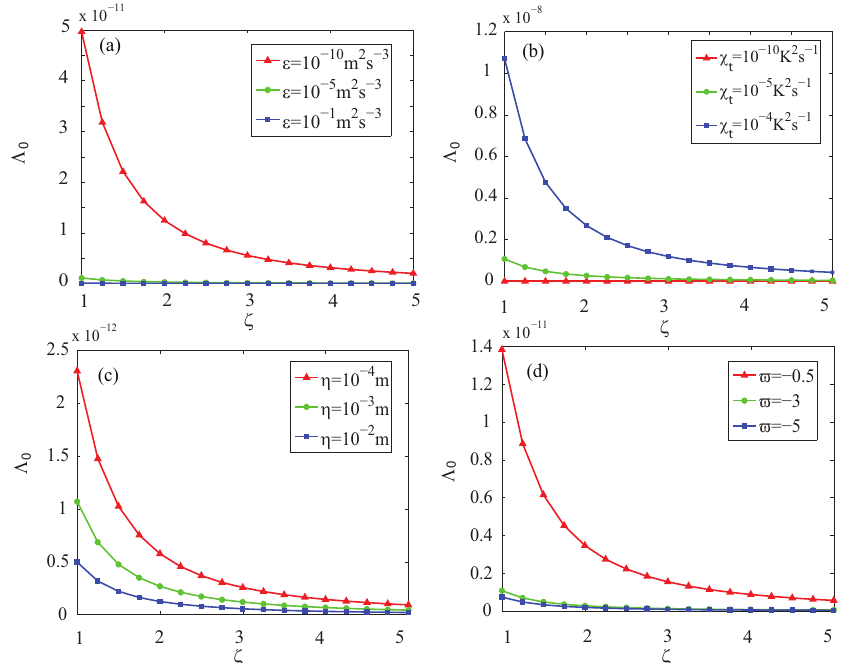
Figure 1. The strength of the anisotropic oceanic turbulence Λ 0 versus the anisotropic coefficient ζ for different dissipation rates of the kinetic energy per unit mass of fluid ε ( a ), dissipation rates of the mean-squared temperature χ t ( b ), the inner scale factor η ( c ), and the temperature–salinity contribution ratio (cid:118) ( d